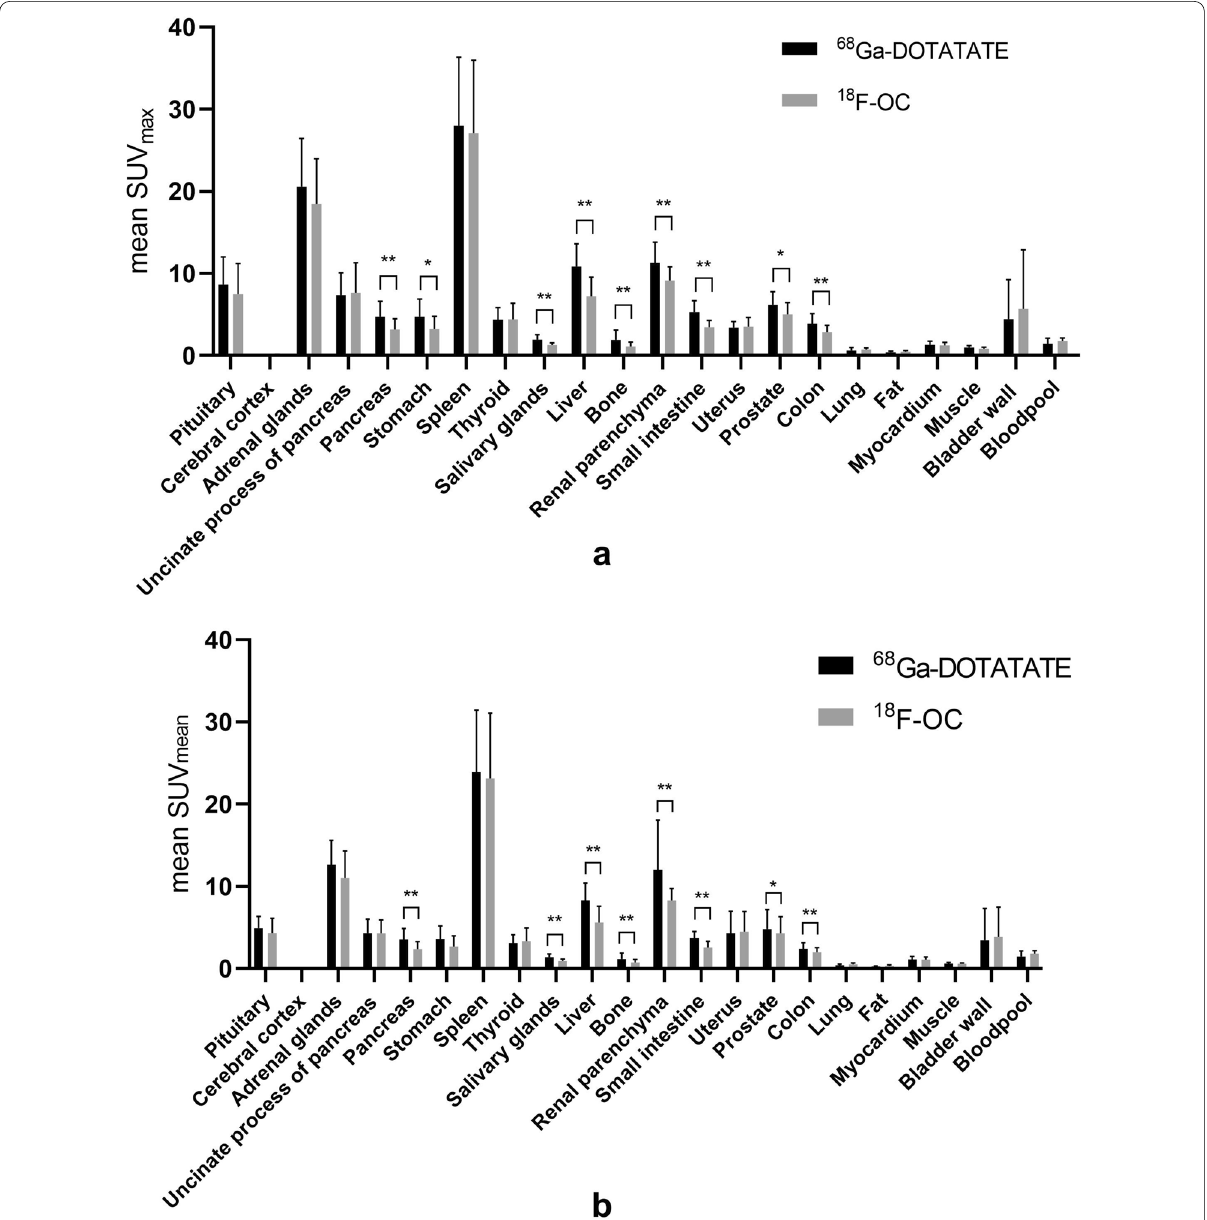
Fig. 1 Uptake of 68 Ga-DOTATATE and 18 F-OC in normal organs was calculated in patients based on the mean SUV max ( a ) and SUV mean ( b ). Significant differences between 68 Ga-DOTATATE and 18 F-OC are indicated. ** : p